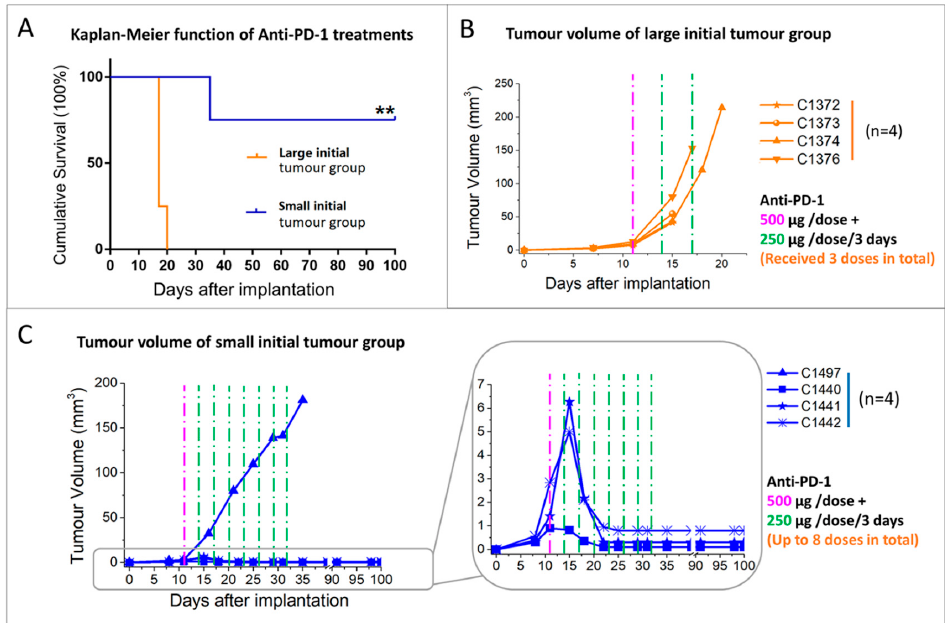
Figure 3A. The tumour growth curves (Figure 3B,C) demonstrated the regression of the tumour observed in most cases from the small initial tumour volume group.